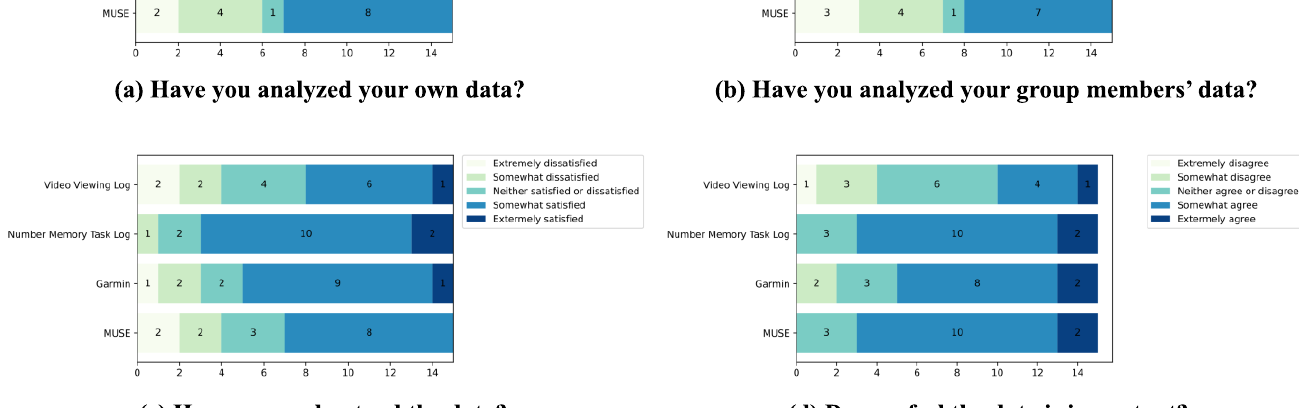
Figure 6. Questionnaire Results: After the last lecture, a questionnaire (Table 2) was administered, to which 15 students responded. The majority of the participants answered that they could analyze, understand, or find the data important except for the video viewing record, while some participants could not analyze, did not understand, or found the video viewing record unimportant.